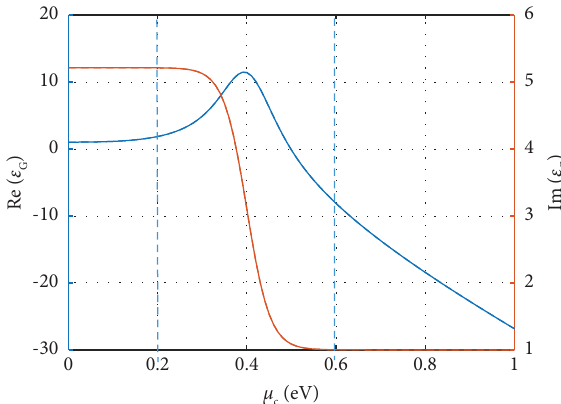
Figure 4: Te permittivity (real and imaginary parts) character- istics of graphene versus the chemical potential show three regions: a high absorption region where graphene behaves as a lossy di- electric medium ( μ c < 0.2 eV) a transition region (0.2eV < μ c < 0.6eV) with median absorption suitable for the tuning process and a region of low absorption with a linear de- pendence where graphene behaves as a quasimetallic medium ( μ c >